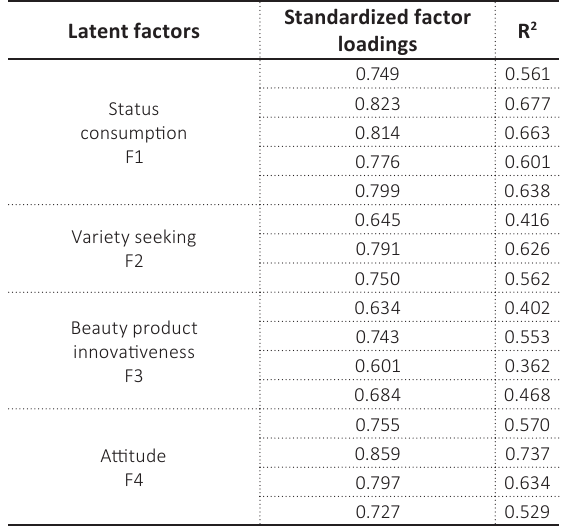
Table 5. Measurement model